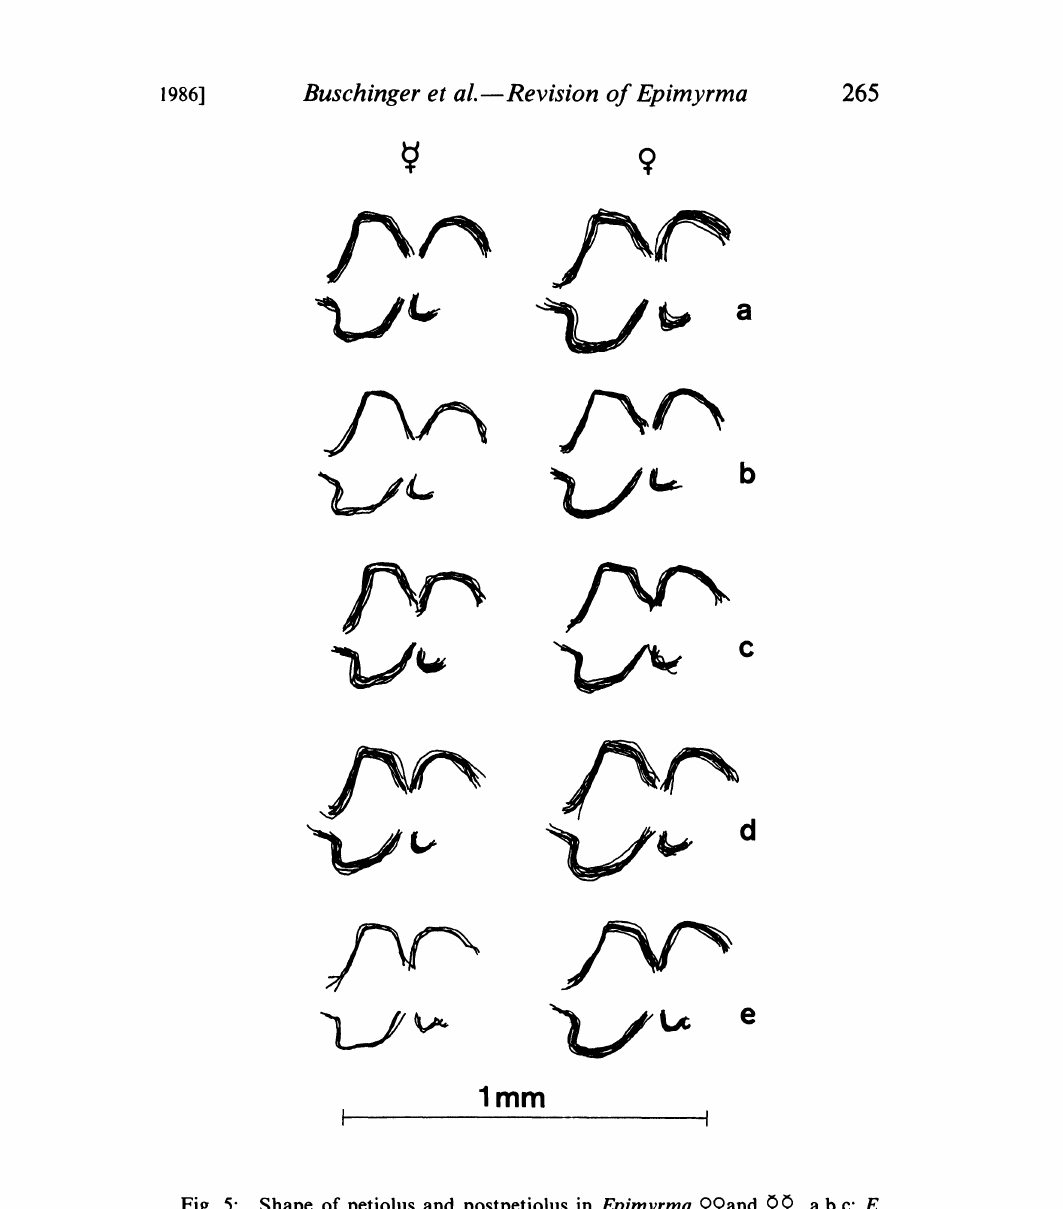
Fig. 5: Shape of petiolus and postpetiolus in Epimyrma QQand kraussei from populations no. (a), 12b (b), 14 (c); d: no. 19 (E. foreli); e: no. 5a (E. vandeli). Usually the drawings of 10 specimens (b: 5, following the method of Wehner